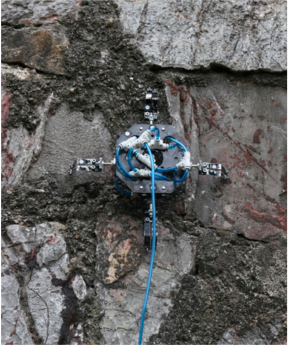
Figure 15. Stably grabbing the granite wall.